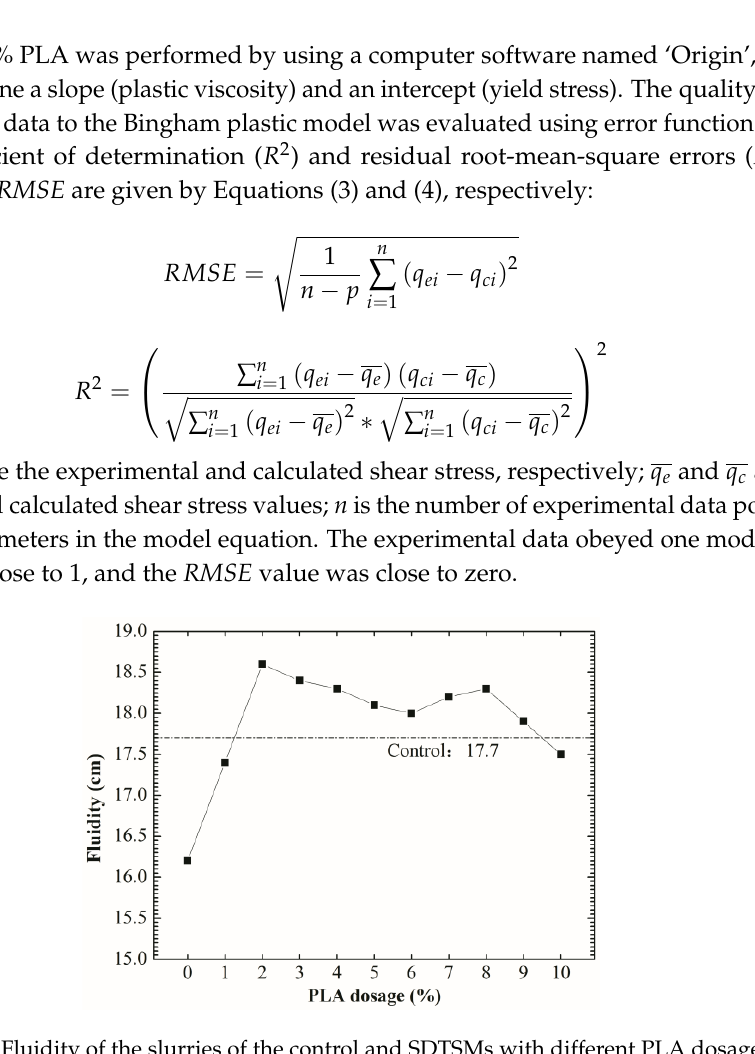
Figure 3. Fluidity of the slurries of the control and SDTSMs with different PLA dosages. Table 3. The values of shear stress (Pa) of slurries of the control and SDTSMs with different PLA dosages at different shear rates.